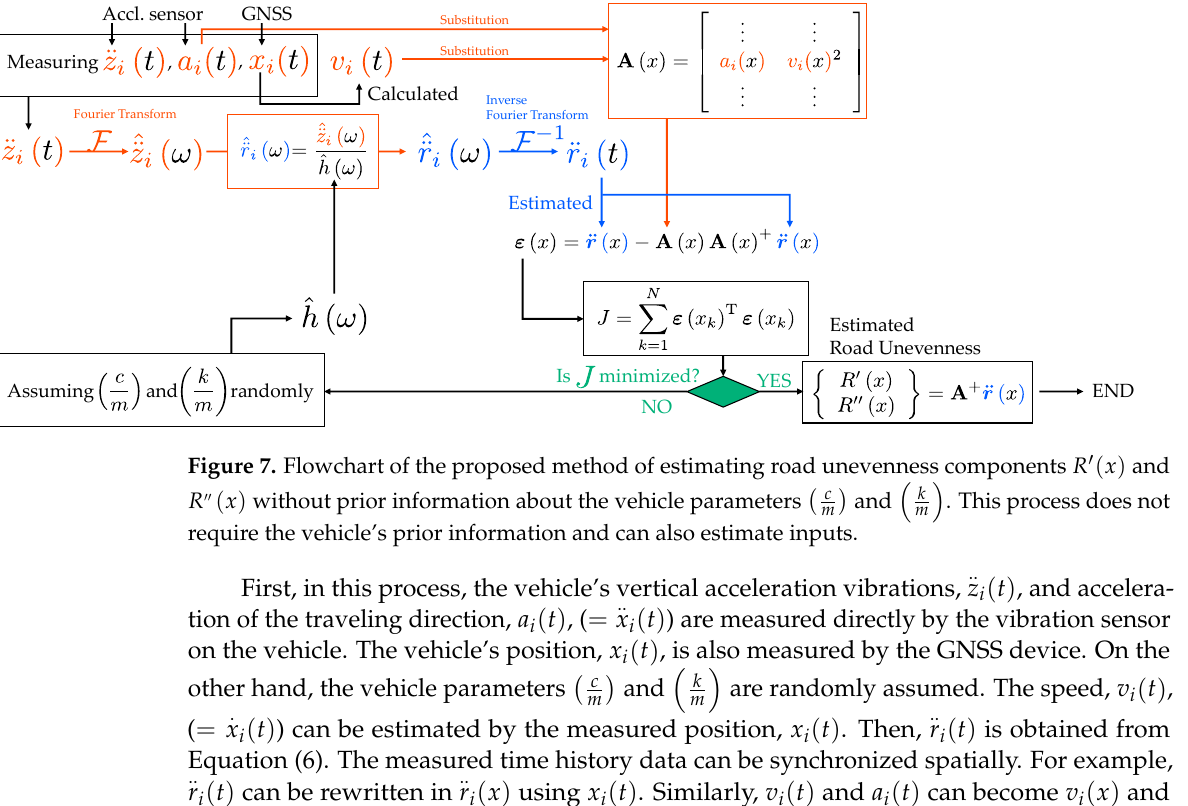
vehicle as well as the vibration data to execute this method.